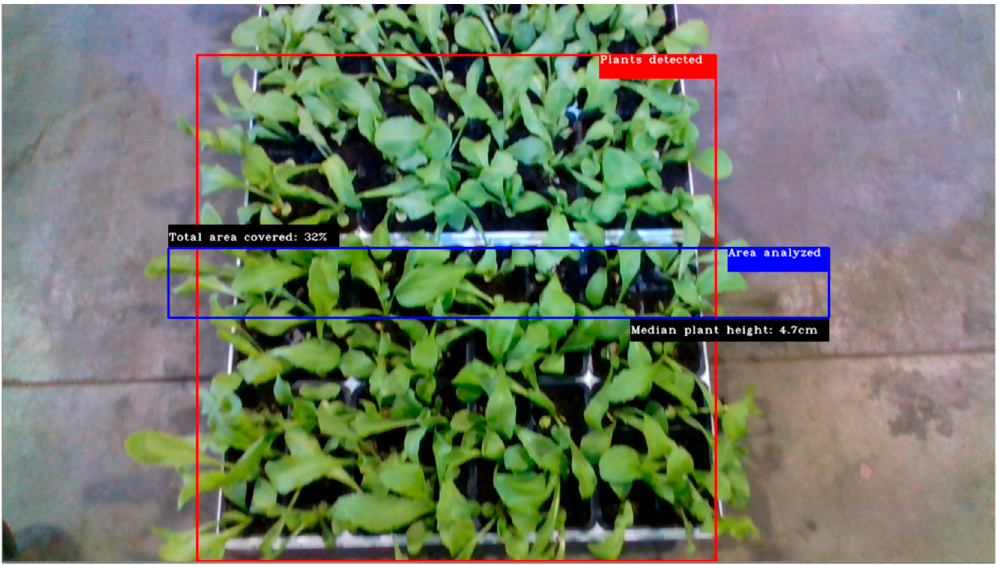
Figure 2. Image processing algorithm output.